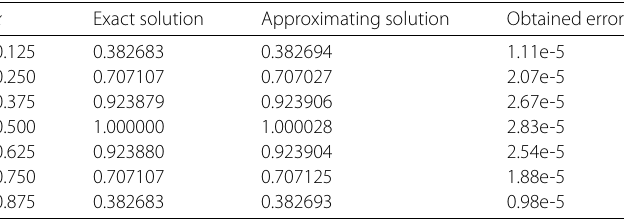
Table 2 Comparison of solutions obtained by the presented method with the exact solution of Example 1 while n =